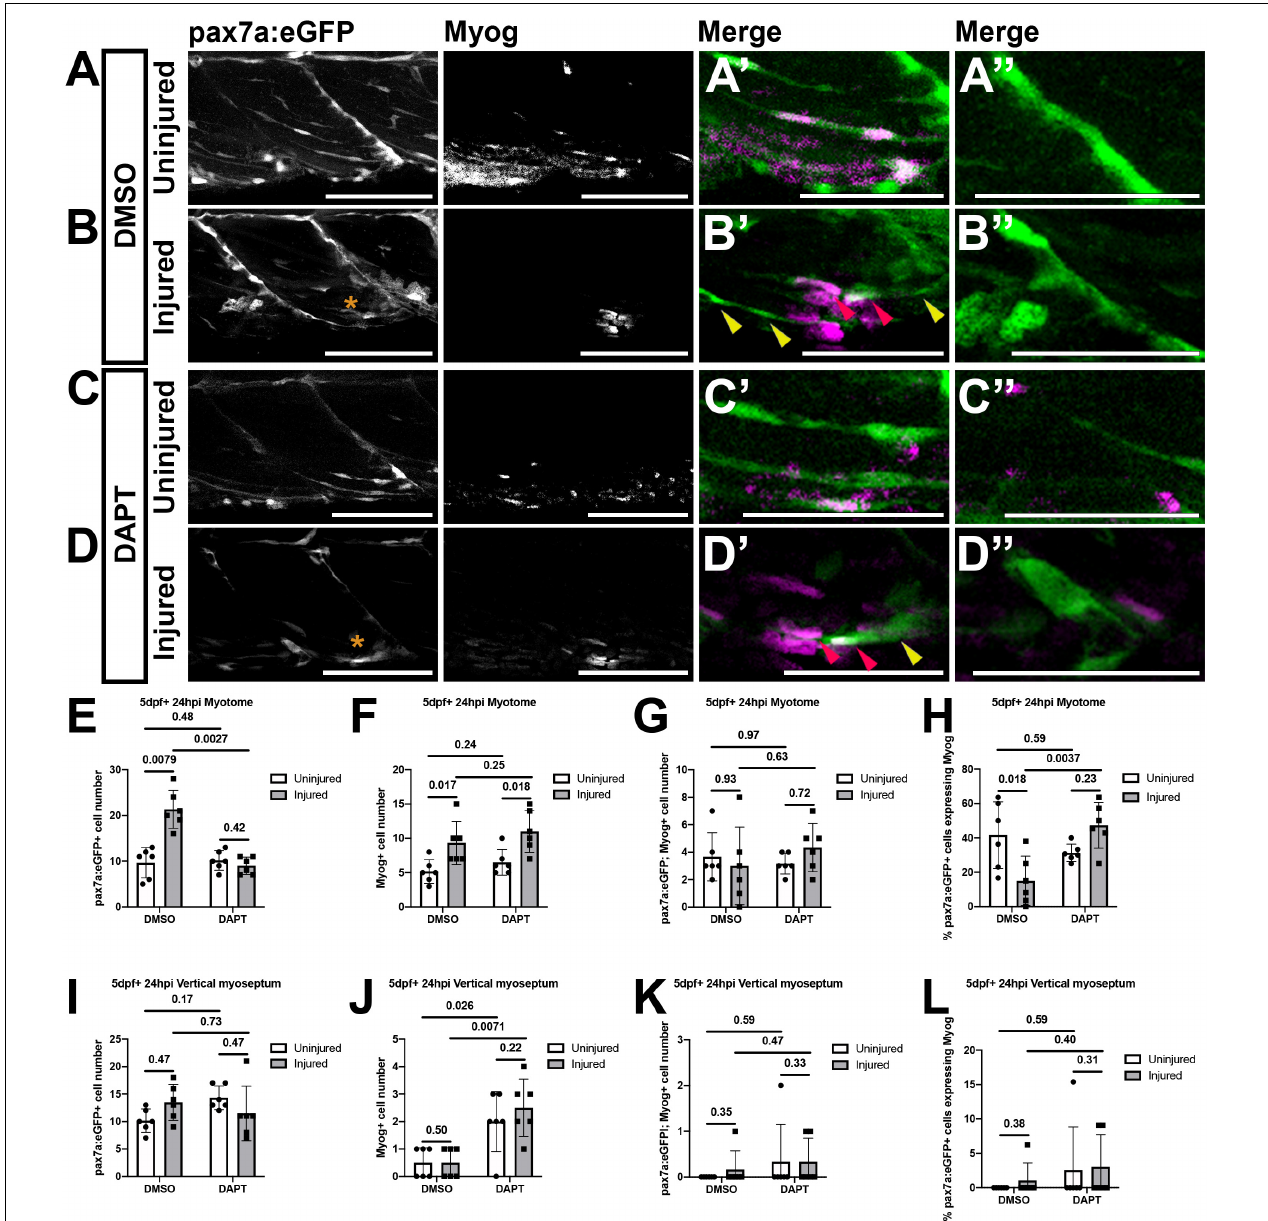
FIGURE 6 | Inhibition of Notch signaling results in an increased differentiation of muSCs responding to injury. Projections of confocal stacks (A–D) of the myotome (A’–D’) and vertical myoseptum (A”–D”) of 5 dpf pax7a:eGFP larvae treated with 1% DMSO (A,B) or 100 µ M DAPT (C,D) prior to (A,C) and after injury (B,D) , fixed at 24 hpi and labeled with anti-Myogenin. pax7a:GFP expressing muSCs with (red arrowheads) and without Myogenin labeling (yellow arrowheads) are recruited to the injury (asterisk) site (B’,D’) . Quantification of pax7a:egfp expressing muSCs (E,I) , Myogenin expressing cells (F,J) and co-labeled cells (G,K) in the myotome (G,H) and both vertical myoseptum (I–K) reveals no significant difference in the number of muSCs expressing Myogenin in DAPT treated compared to DMSO treated animals ( p > 0.05, G,K ). Examination of the proportion of pax7a:eGFP expressing muSCs expressing Myogenin in the myotome (H) and vertical myoseptum (L) reveals a significantly increase in those expressing Myogenin in the presence of DAPT following injury in the myotome ( p < 0.05, H ). Significant differences were tested by 2-way ANOVA ( n = 24) with Tukey’s HSD post hoc test or by transforming data by ART and performing 2-way ANOVA followed by a Dunn’s test with Benjamini and Hochberg correction. Errors bars display standard deviation and values above bars indicate significance ( p -values). Scale bars: 100 µ m (A–D) , 50 µ m (A’–D’,A”–D”)